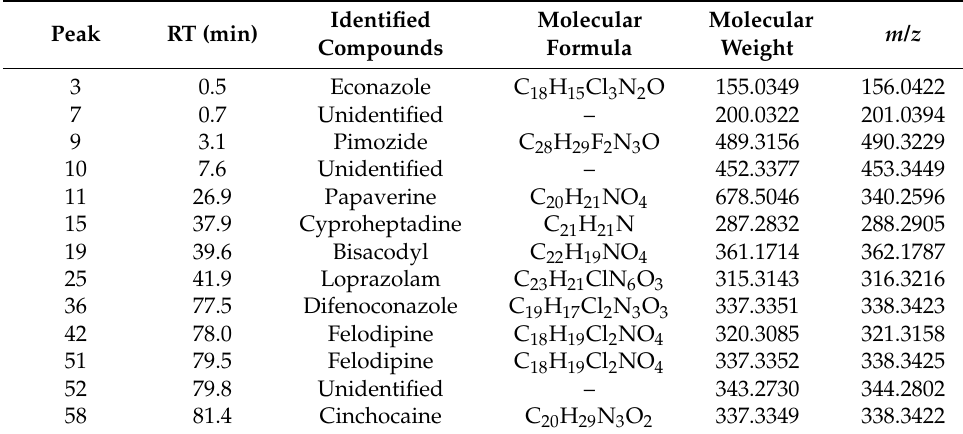
Figure 4. The compounds identified in D. sublaevigata are tabulated in Table 8 along with